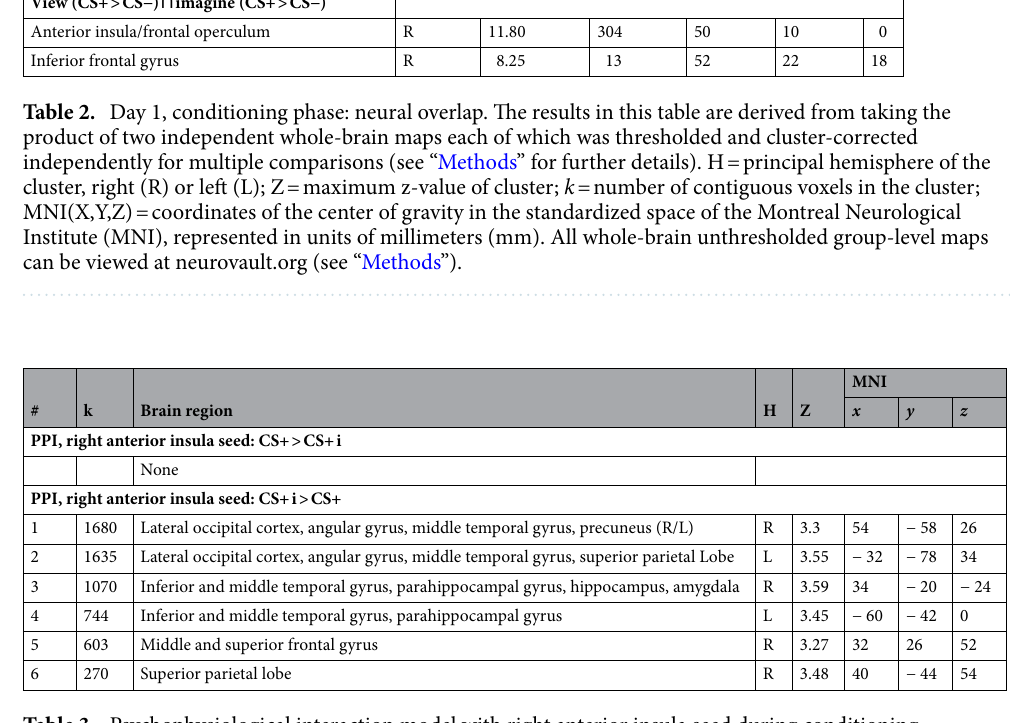
Table 3. Psychophysiological interaction model with right anterior insula seed during conditioning phase. # = the number of a cluster, ordered by size; k = the number of contiguous voxels in the cluster; Brain region = the region(s) in the broader cluster. The region names are taken from the Harvard–Oxford atlas in FSL; H = principal hemisphere of the cluster, right (R) or left (L); Z = maximum z-value from the cluster within the given brain region; MNI(X,Y,Z) = coordinates of the voxel with the maximum effect in the standardized space of the Montreal Neurological Institute (MNI), represented in units of millimeters (mm). All whole-brain unthresholded group-level maps can be viewed at neurovault.org (see “Methods”).